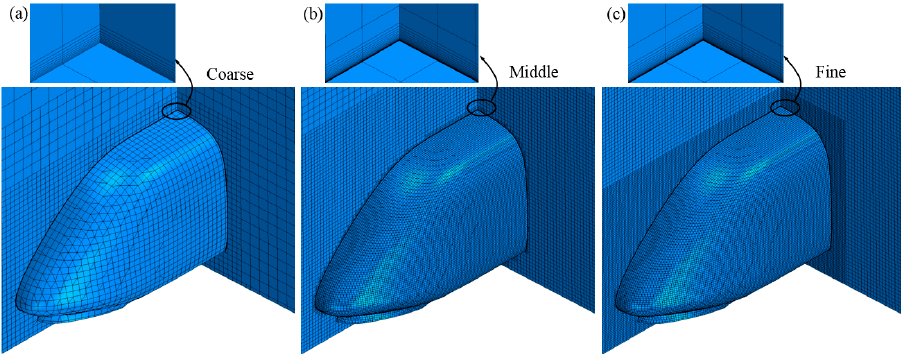
ff erent type grids: ( a ) coarse, ( b ) middle, and ( c ) fine. Figure 3. Different type grids: ( a ) coarse, ( b ) middle, and ( c ) fine. Figure 3. Di